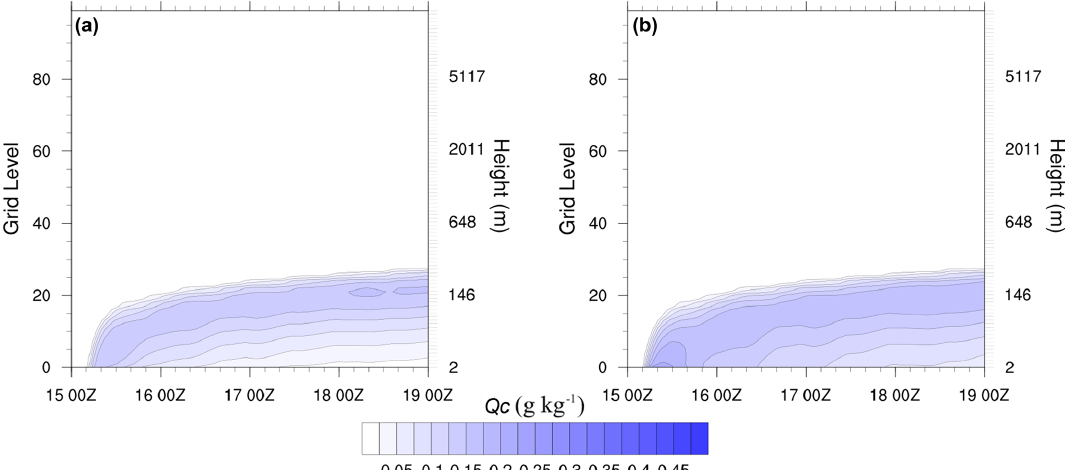
Figure 1. Contours of Q c (gkg − 1 ) generated by WRF SCM, with 6h of surface cooling at 3Kh − 1 . (a) MYNN boundary layer, using the turbulence deposition scheme described with z 0c = 0 . 01m, plus Thompson microphysics with gravitational settling. (b) Original MYNN module with gravitational settling only in Thompson microphysics. The full vertical domain is shown to indicate that no upper-level cloud formed in these cases (it did with other input). Times on the x axis are in the format DD HHZ (day, hour in UCT(Z)), with small tick marks 4h apart. The run start time was